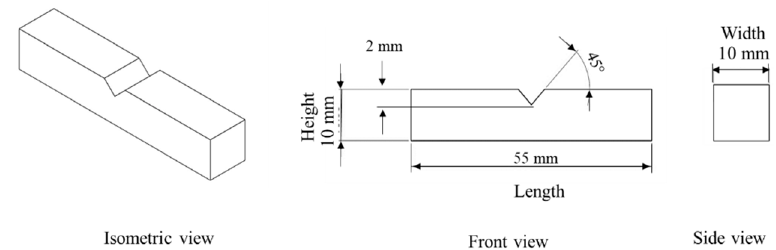
Figure 1. The geometry of the test specimen.